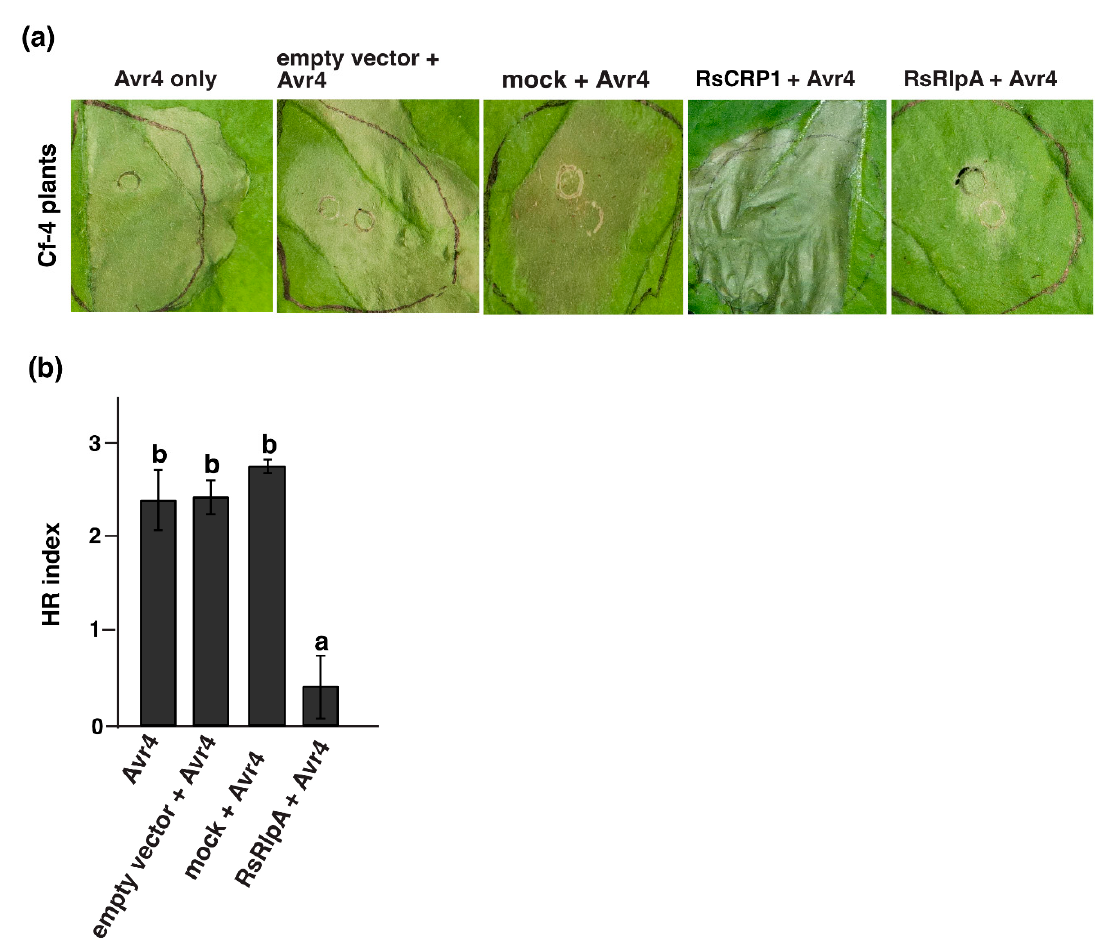
Figure 4. The RsRplA effector suppresses the Avr4-mediated hypersensitive response (HR). ( a ) HR suppression assay by the RsRplA on N. benthamiana expressing the Avr4/Cf4 complex. ( b ) HR index-scale from 0–3 with “0” indicates no symptoms and “3” severe symptoms on N. benthamiana . Leaves were Agro-infiltrated first with the RsRlpA effector driven by the 35S promoter and HR challenged 24hpi with the Avr4 effector. Agro-infiltration with: empty vector, induction buffer (mock) or the RsCRP1 candidate effector protein were used as negative controls. Images taken 3dpi. Different letters ( a , b ) indicate significant differences according to Tukey’s test ( p < 0.05). Error bars represent SD of